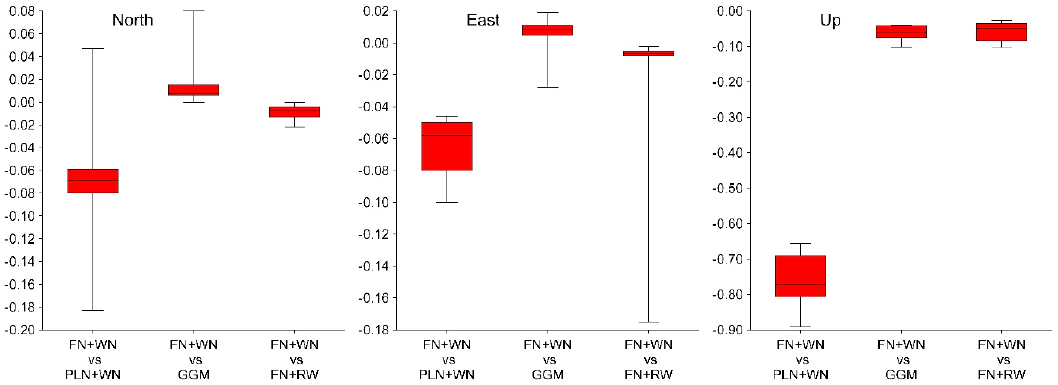
Figure 7. Velocity differences (mm/yr) of the GOA_2 solution between selected noise models. The lines represent the median, the boxes represent 50% of the values, and the whiskers extend to the highest and lowest values (excluding outliers); the box length is the interquartile range.